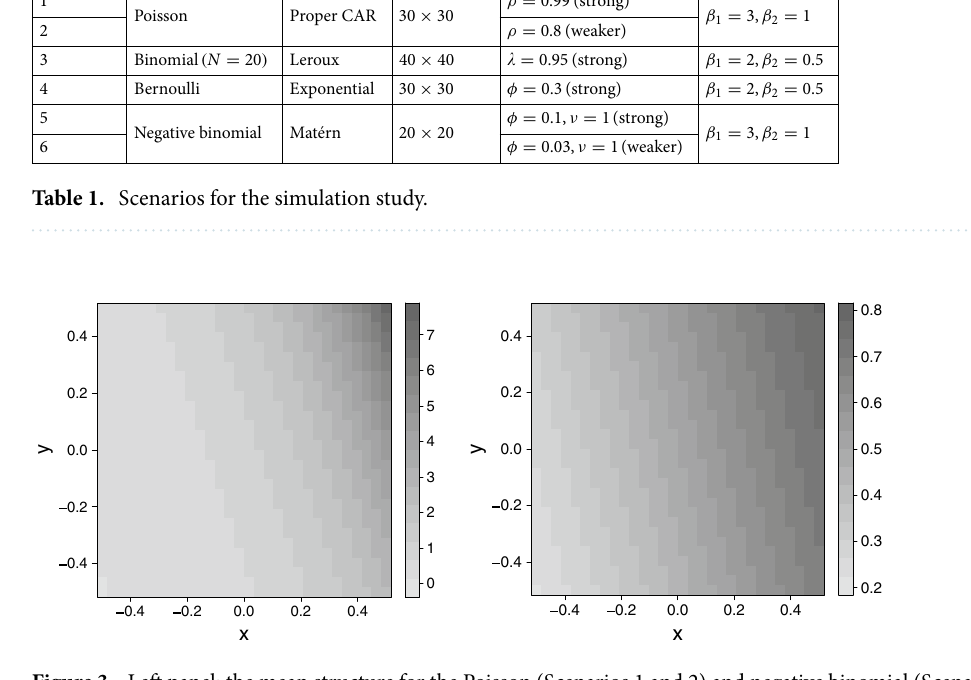
Figure 3. Left panel: the mean structure for the Poisson (Scenarios 1 and 2) and negative binomial (Scenarios 5 and 6) simulation studies. Right panel: the mean structure for the binomial (Scenario 3) and ungrouped